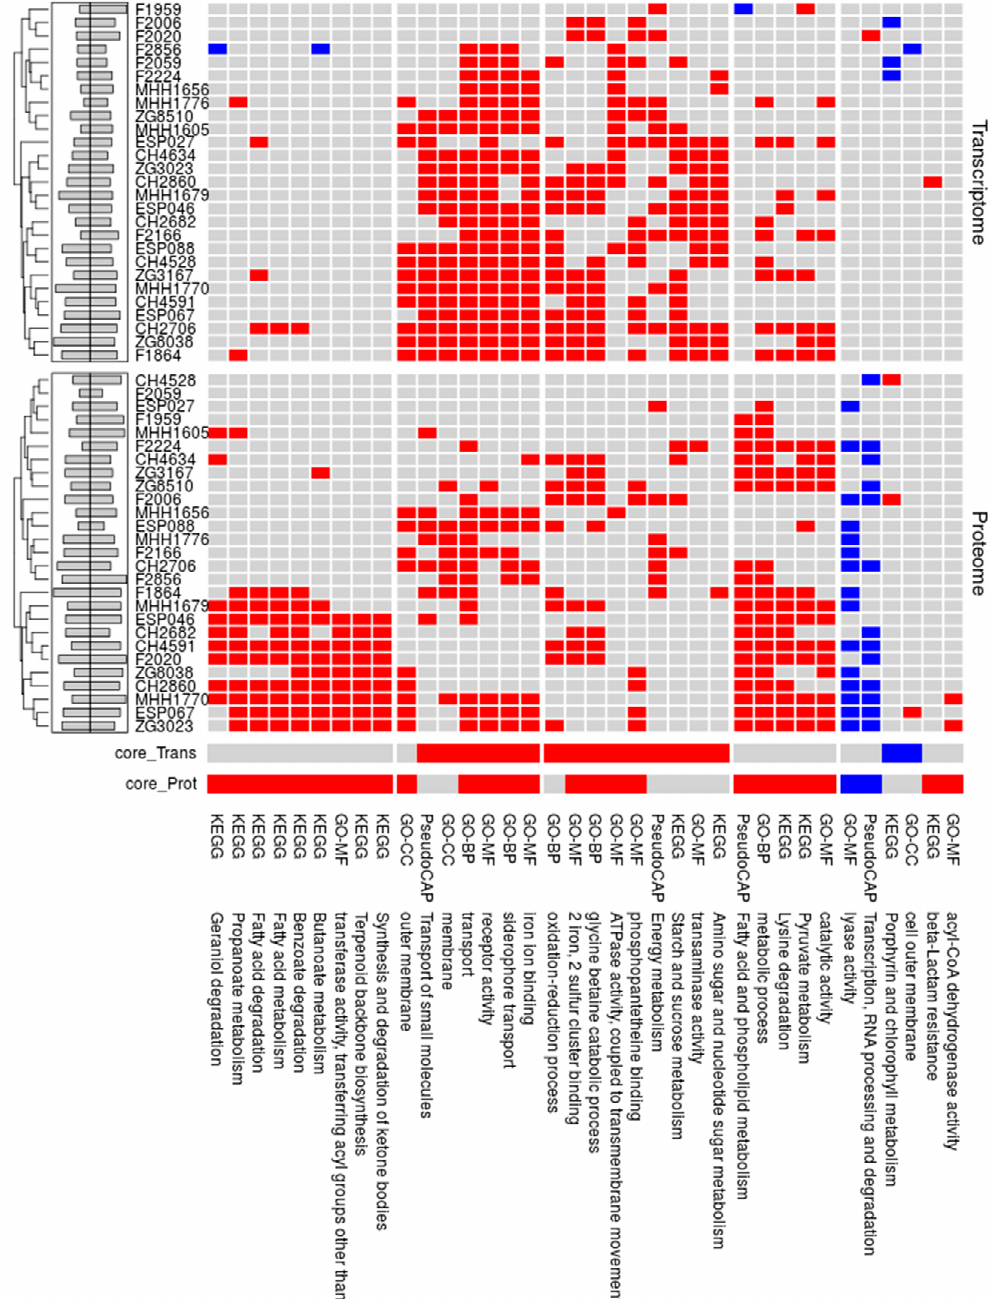
Figure A3. Functional enrichment biofilm/planktonic in protein and mRNA.All functional categories that were enriched (p-value < 0.05) in the group of proteins or transcripts with a differential expression under biofilm as compared to planktonic growth conditions are listed. The function that is enriched in proteins that are up-regulated under biofilm condition in the individual isolates (x-axes) is colored in red and down-regulated in blue. Barplots indicate how many proteins are up- and down-regulated in the individual strains. Core_Trans and core_Prot represent all isolates seen as biological replicates. Functions are derived from KEGG- (1), PseudoCAP- (2) or gene ontology(GO)- (3) annotations. GO-MF = molecular function, GO-BP = biological process, GO-CC = cellular component.